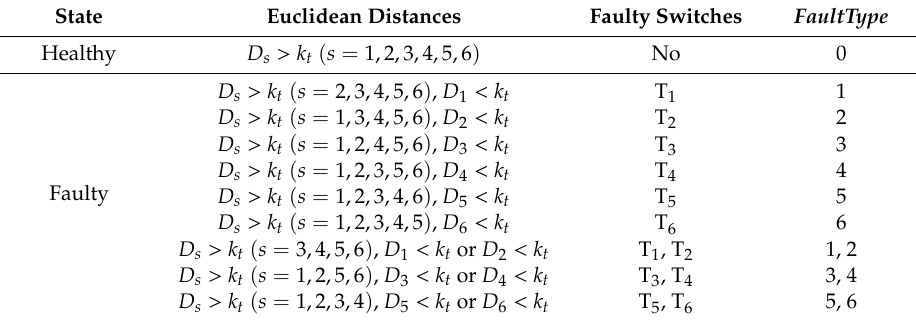
Table 5. Proposed fault diagnosis